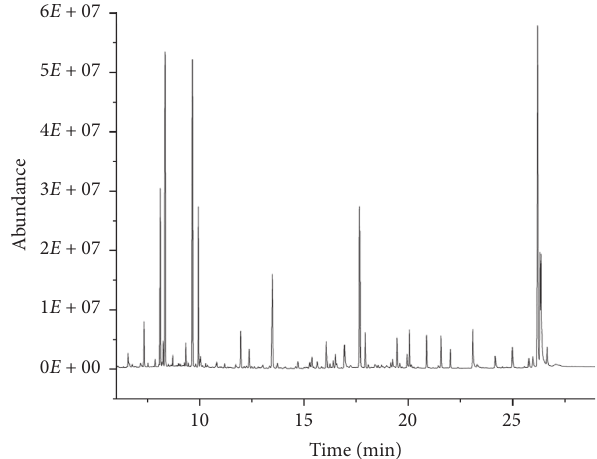
Figure 1: The total ion chromatograms (TICs) of rat bladder cancer urine